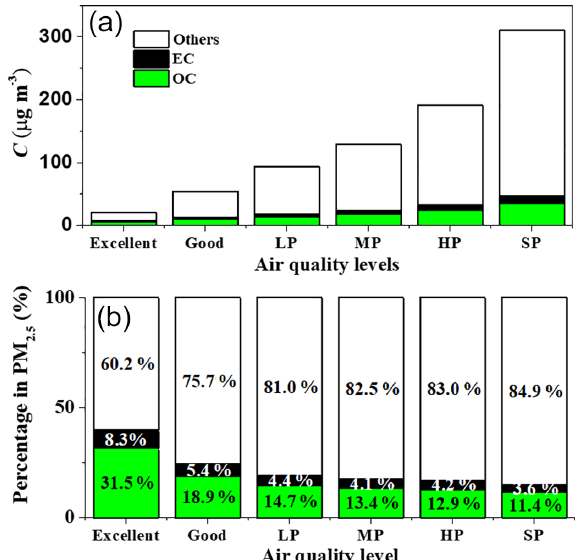
Figure 2. Variation in average OC, EC, and PM 2 . 5 concentrations (a) and in the percentages of OC, EC, and other components in PM 2 . 5 (b) for different air quality levels.